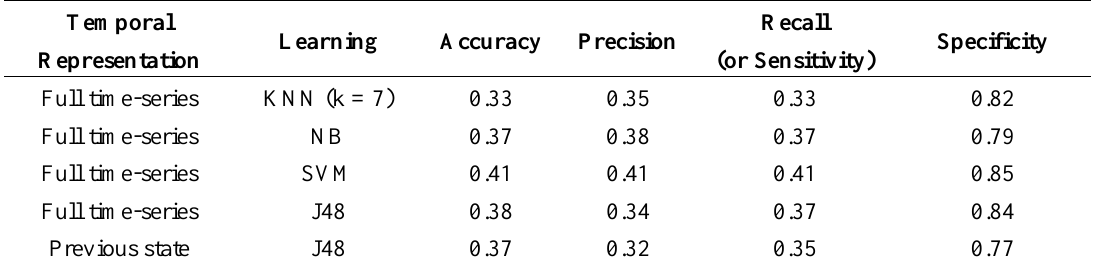
Table 2. Prediction of emotional functions of people with